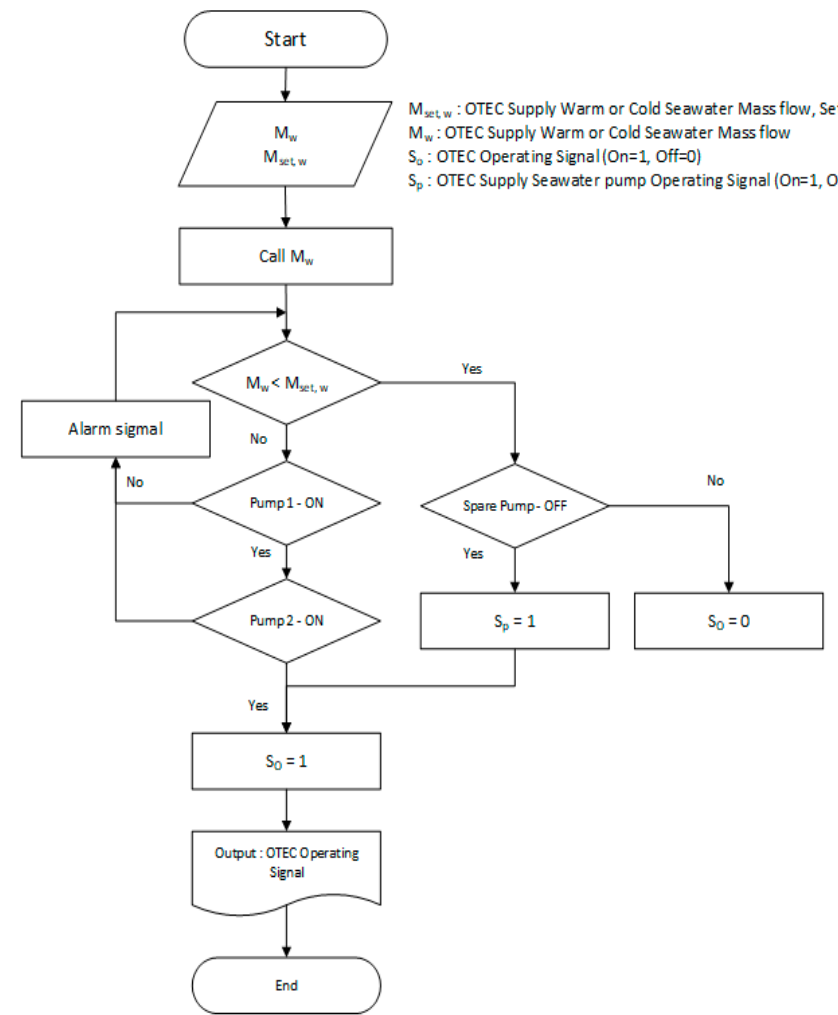
Figure 7. Control logic of surface and deep seawater pumps.